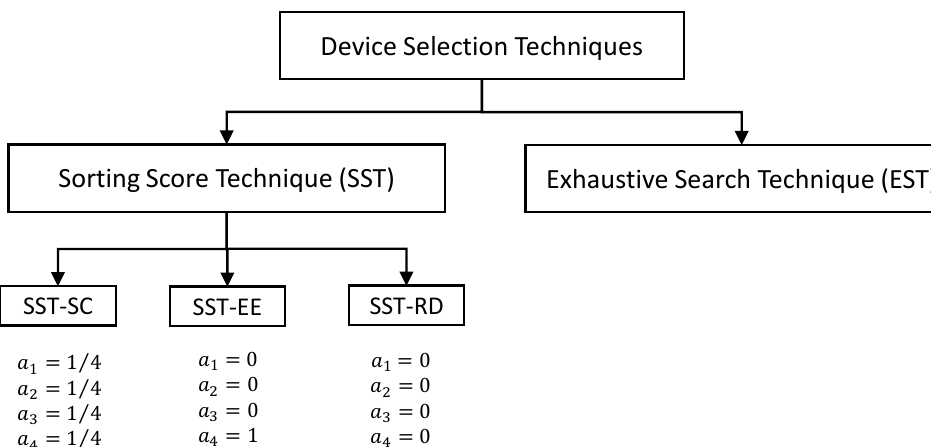
Figure 5. Block diagram describing the different device selection techniques.